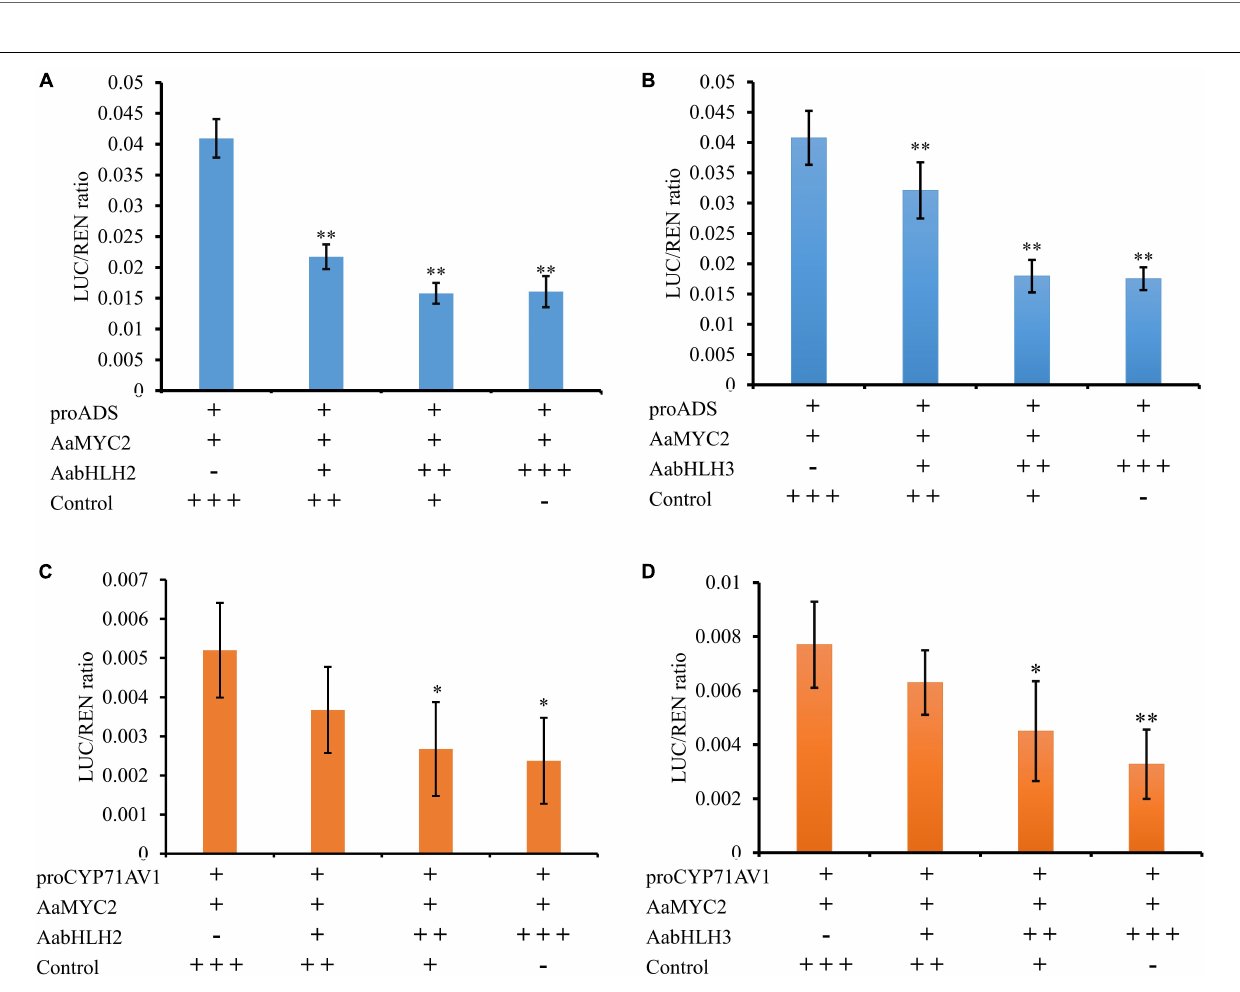
FIGURE 6 | AabHLH2 and AabHLH3 were competing with AaMYC2 to the target gene promoters. (A,B) The competition effect of AabHLH2/AabHLH3 with AaMYC2 in regulating ADS promoter, the activation of the ADS promoter was attenuated in a dose-dependent manner when co-expressing of AabHLH2 /AabHLH3 and AaMYC2 , respectively. (C,D) The competition effect of AabHLH2/AabHLH3 with AaMYC2 in regulating the CYP71AV1 promoter, the activation of the CYP71AV1 promoter was attenuated in a dose-dependent manner when co-expressing of AabHLH2 /AabHLH3 and AaMYC2 , respectively. The values were reached by calculating the relative ratio of LUC activities to REN activities (LUC/REN), and the GFP was added as a control. Data are means ± SD ( n = 4). Student’s t -test: ∗ , P < 0.05; ∗∗ , P <